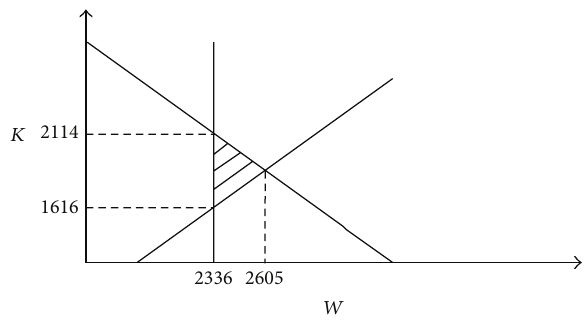
Figure 2: Appropriate